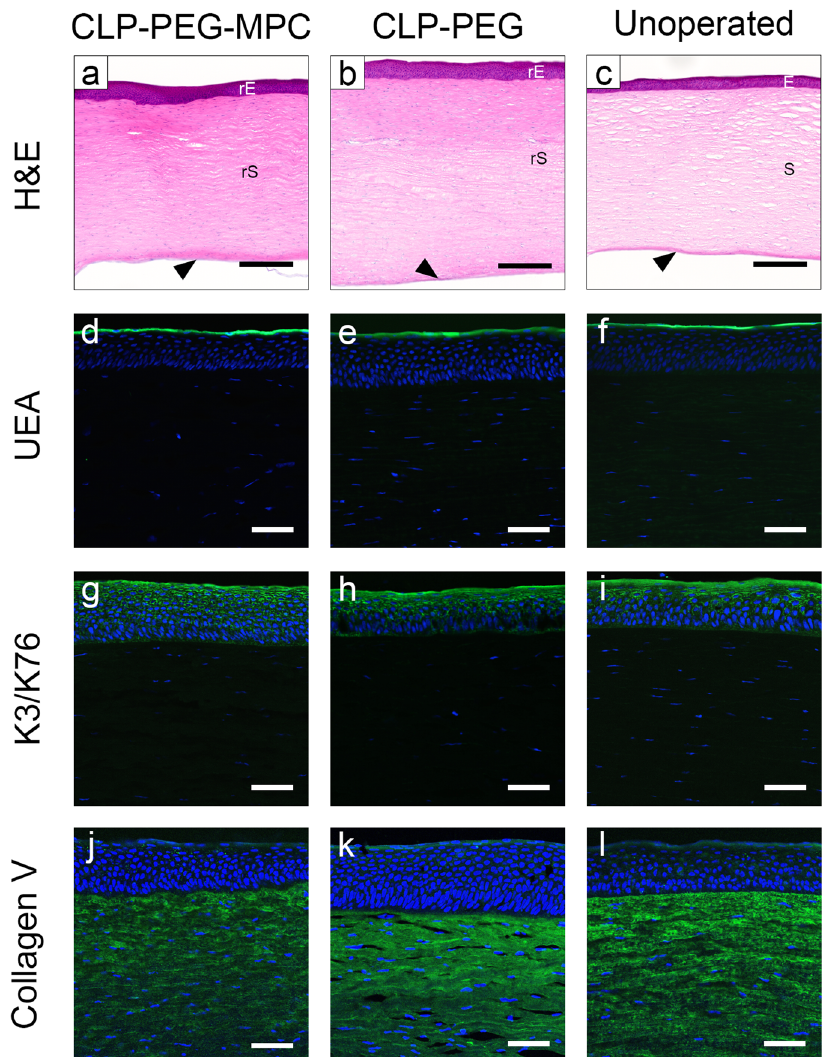
Fig. 5 Regenerated mini-pig neo-corneas at 12 months after post-CLP-PEG-MPC implantation compared to CLP-PEG and controls. a – c Hematoxylin and eosin staining of the implanted corneas shows morphological similarity of the regenerated epithelium (rE) and stroma (rS) to the epithelium (E) and stroma (S) of an unoperated, healthy control cornea. The unoperated endothelium (arrowheads) remained intact in all samples. d – f Positive Ulex Europaeus Agglutinin lectin staining shows the presence of a tear fi lm in both regenerated corneas and the control. g – i Terminally differentiated corneal cells were cytokeratin 3/76-positive in both regenerated neo-corneas. j – l Collagen V staining of the neo-cornea stromas shows the regeneration of corneal speci fi c ECM components. Black scale bars, 500 µ m; white scale bars, 200 µ